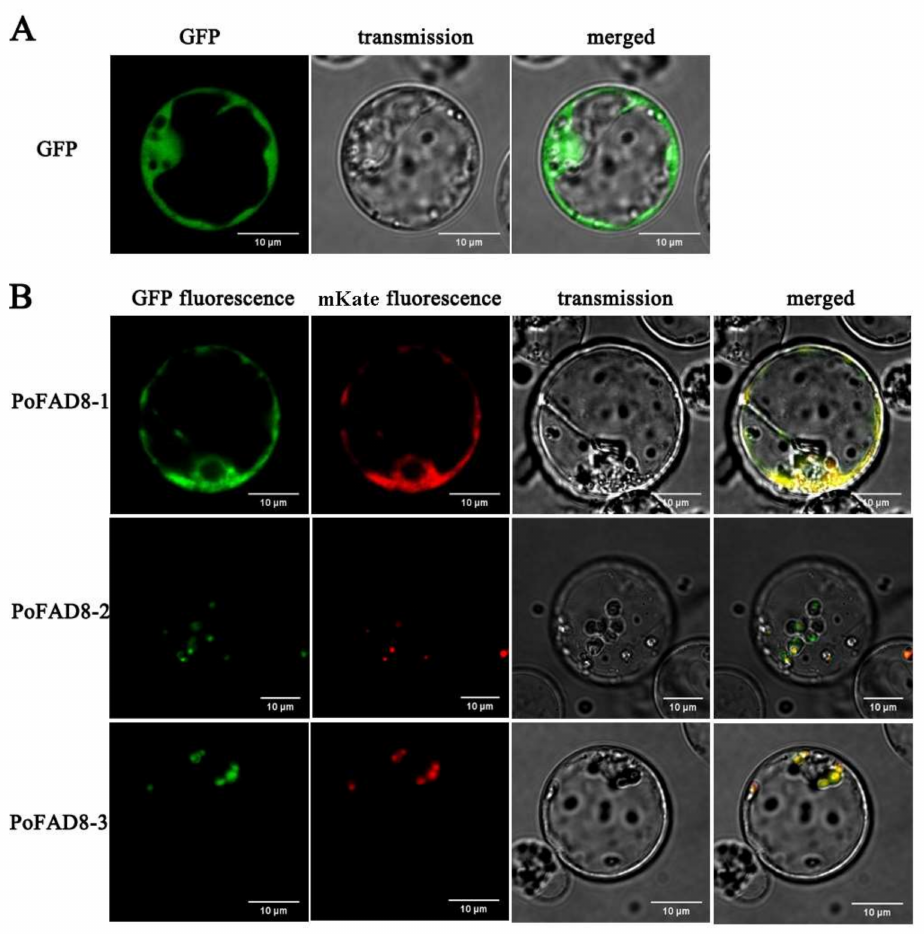
Figure 3. Subcellular localization of PoFAD8-1 , PoFAD8-2 , and PoFAD8-3 in rice